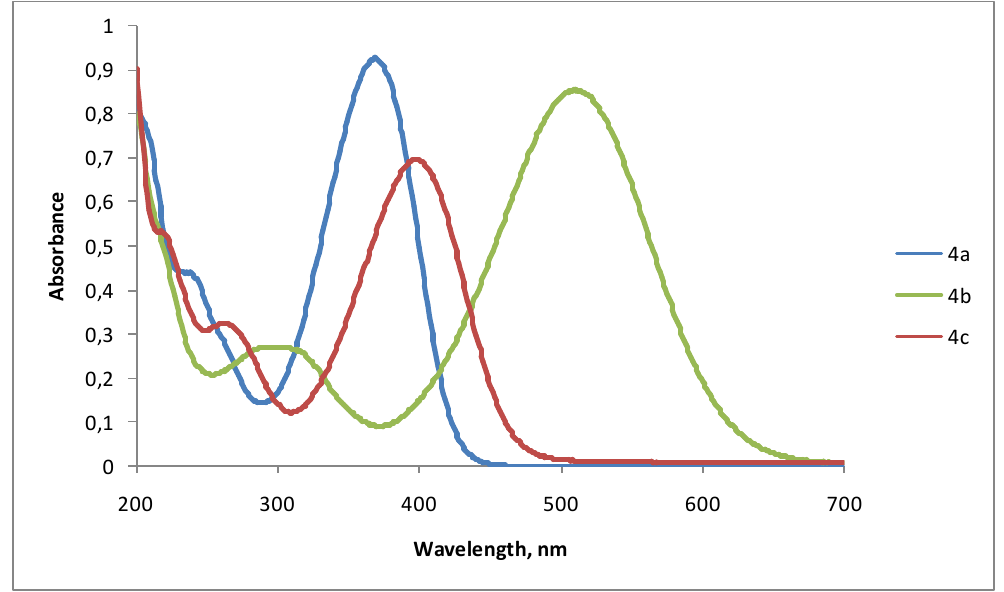
Figure 6. UV – Vis spectra of compounds 4a – c in MeCN (2 × 10 −5 M). Figure 6. UV–Vis spectra of compounds 4a – c in MeCN (2 × 10 − 5